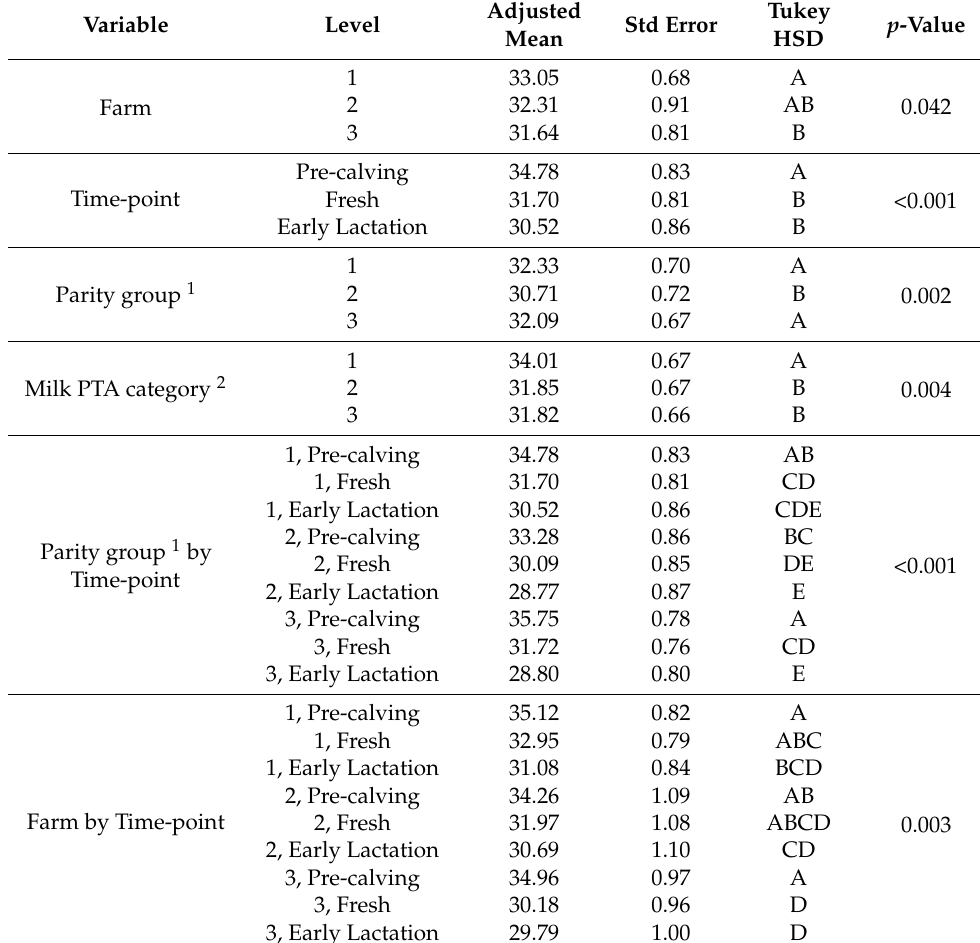
Table 1. Results from a multivariable mixed effects linear regression model for outcome muscle thickness (mm). HSD: Honestly significant difference; levels within a variable with different letters are statistically significantly different ( p < 0.05).